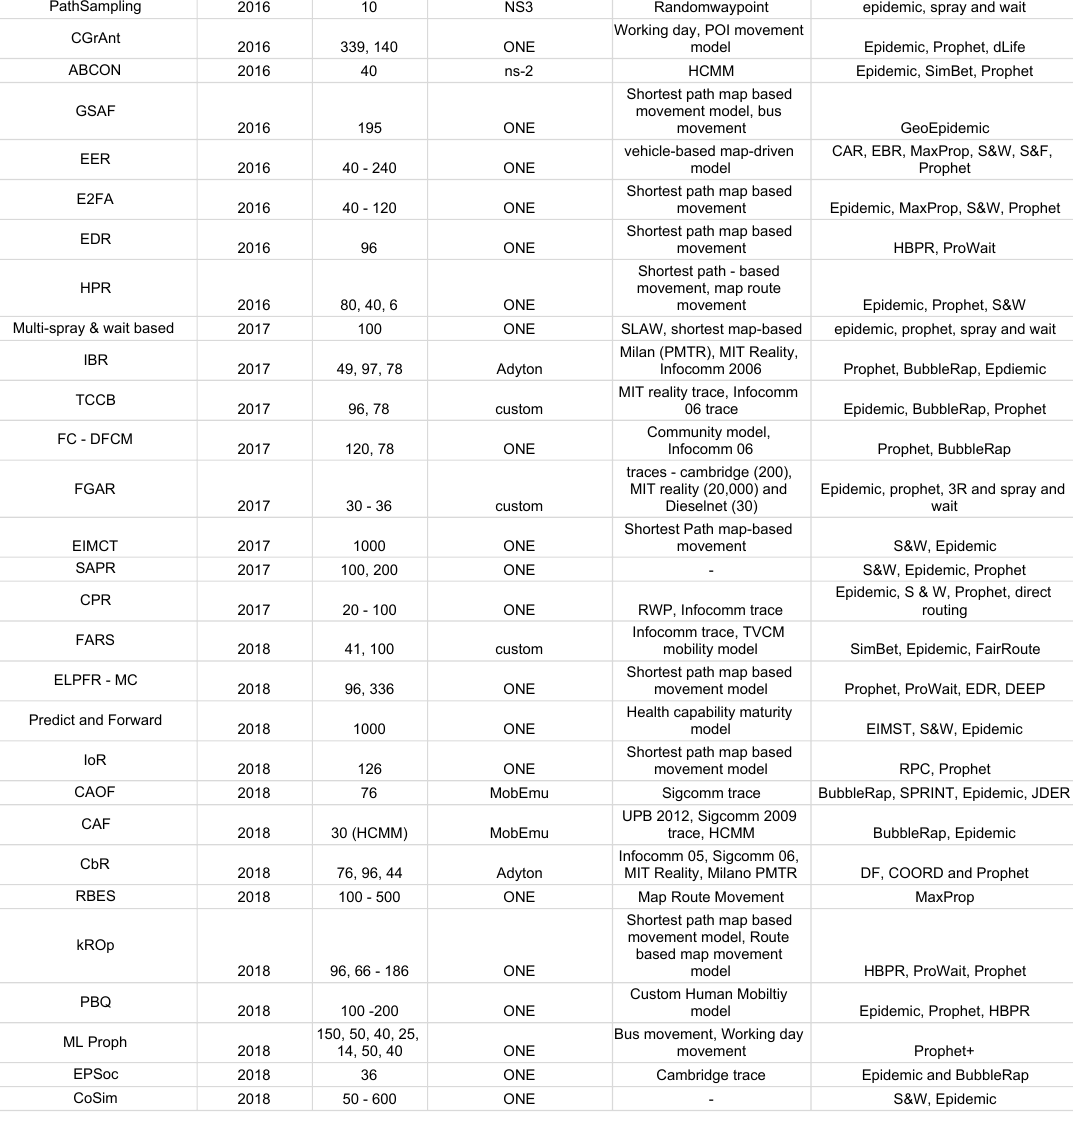
Figure A2. Evaluation environment analysis from surveyed